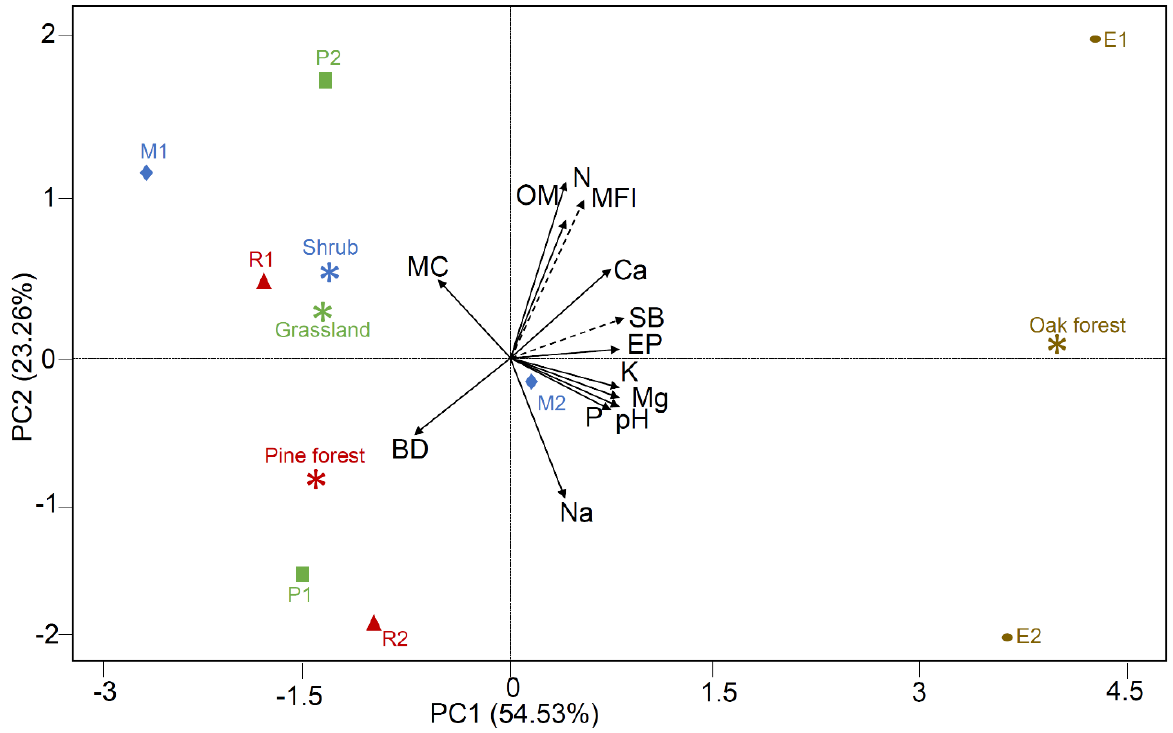
Figure 4. Plot of cases and variables in the PCA plane for soil plot data. The plotted points correspond to the centroids of cases for each plot and type of vegetation. Variable description and acronyms are explained in Table 1.